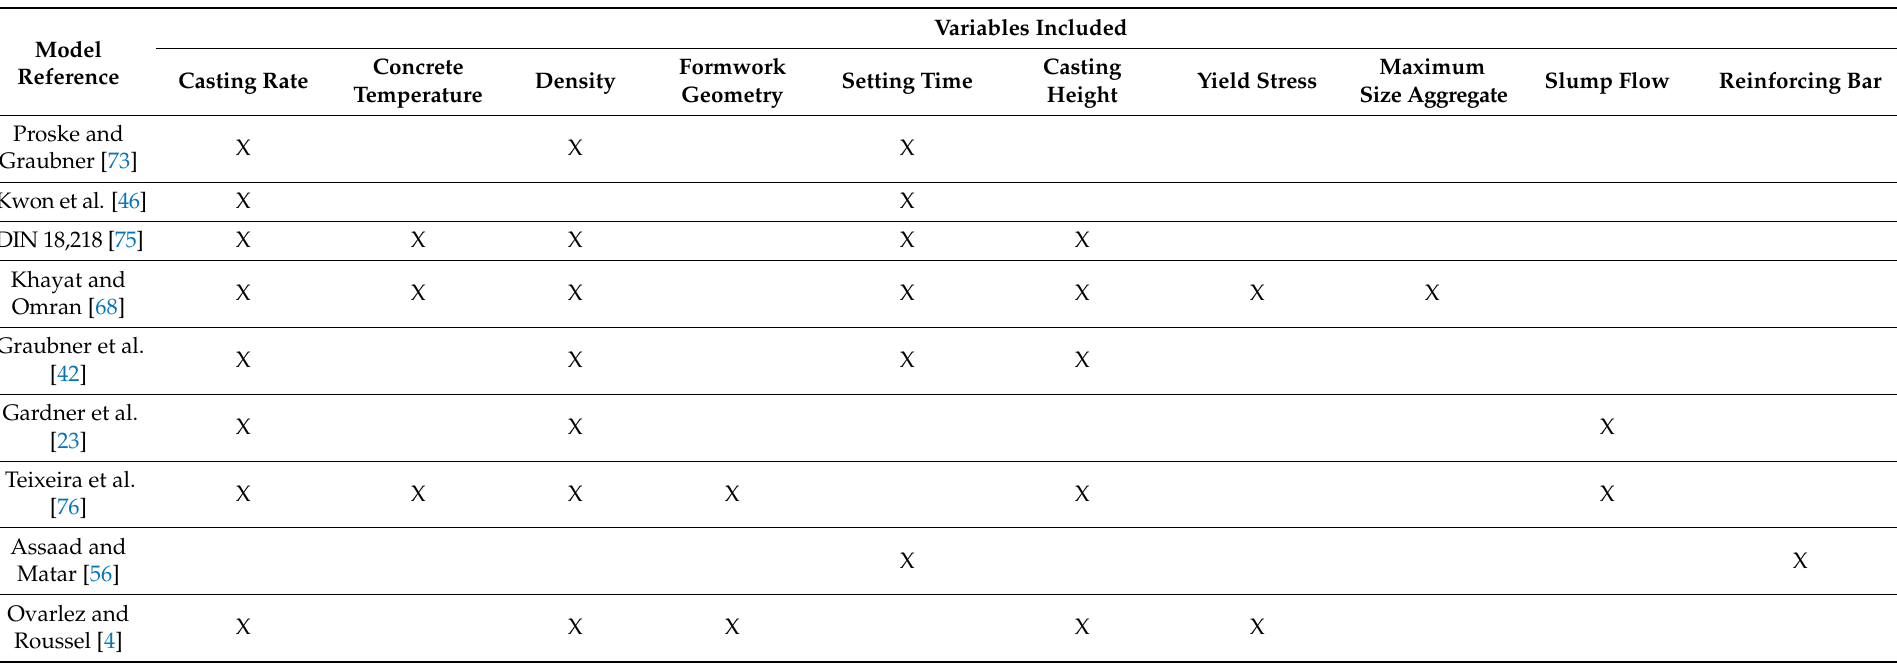
Table 3. Form pressure variables included in the mathematical